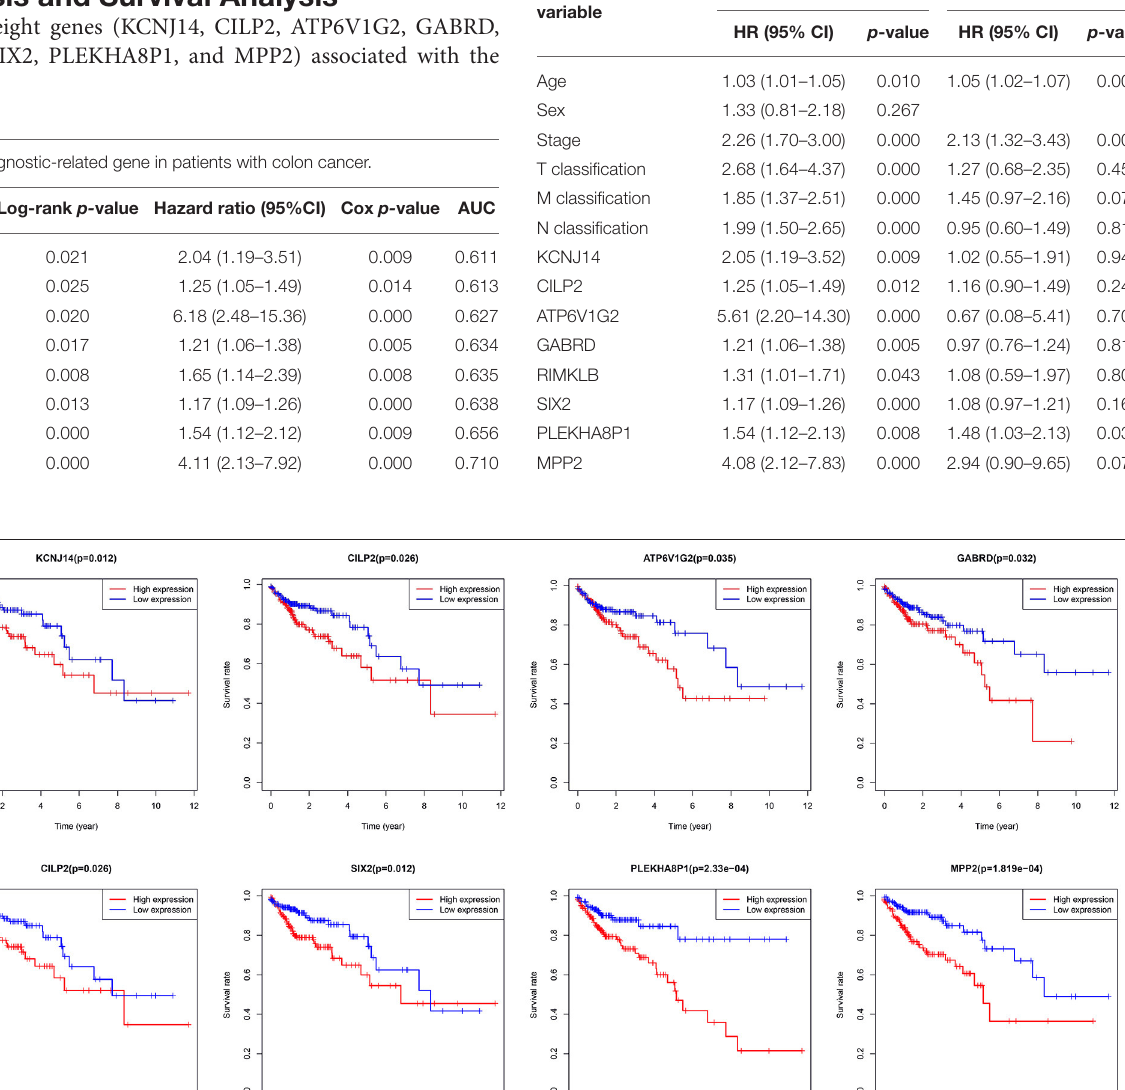
TABLE 3 | Univariate analysis and multivariate analysis of the correlation of prognostic-related genes with overall survival among patients with colon cancer. Clinicopathologic variable